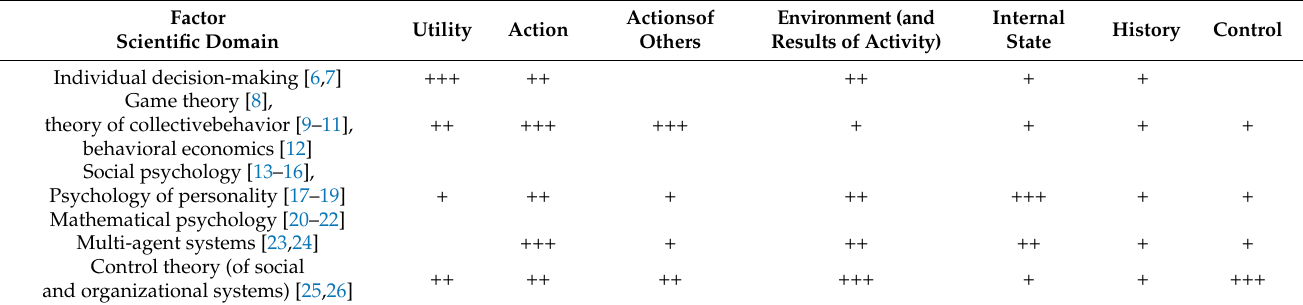
Table 1. Decision-making factors and related scientific domains.